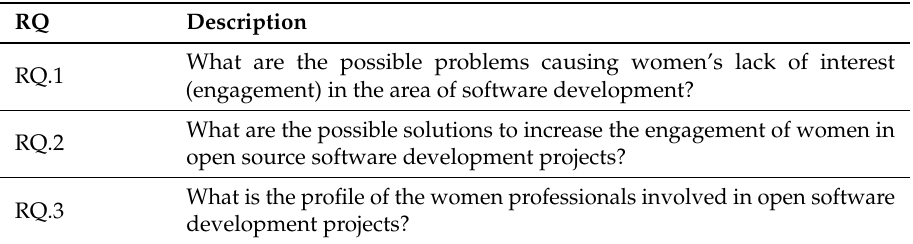
Table 1. Research questions